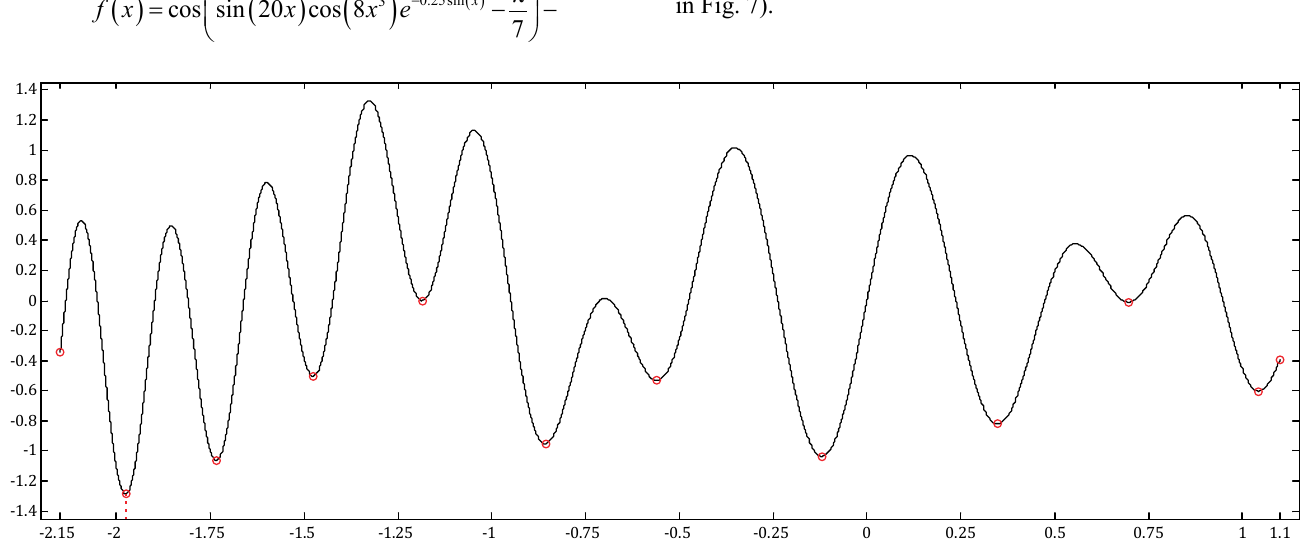
Fig. 6. The 12 local minima, including both the local boundary minima and the global minimum (marked by the dotted line downward) of function (43) on interval [ − 2.15; 1.1].